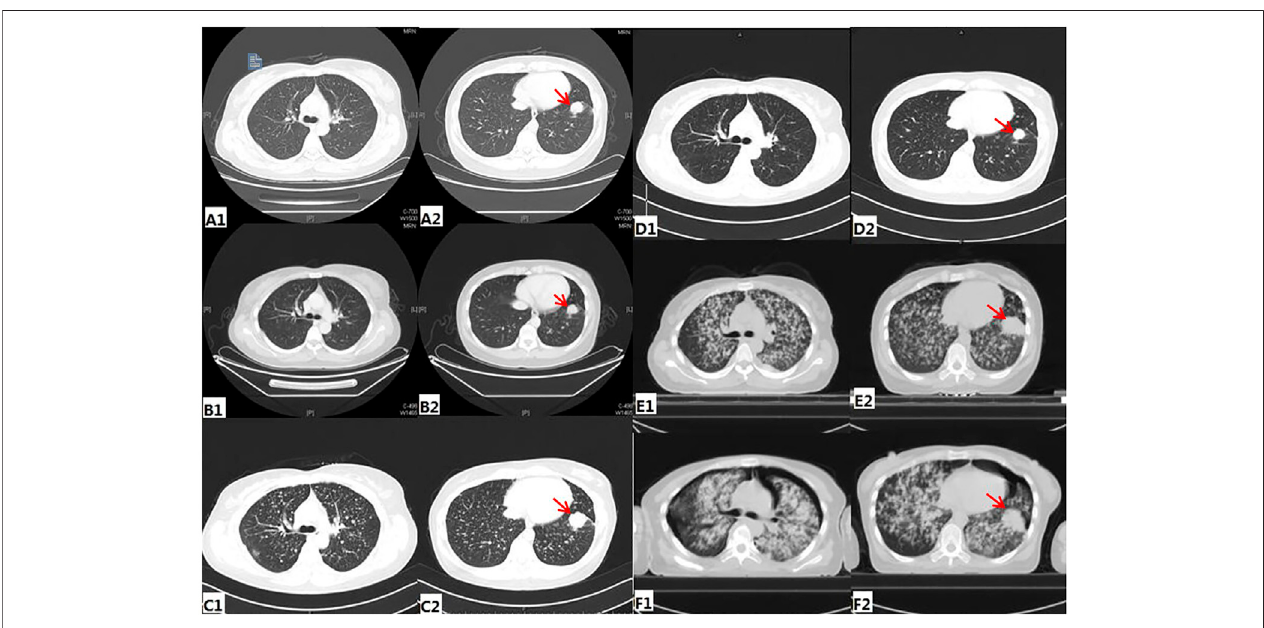
FIGURE1 | Radiologic fi ndings during treatment (A) before any treatment (B) Post-treatment image after three cycles of pemetrexed and cisplatin (C) before Afatinib treatment (D) CT of the chest showing PR after 1month of Afatinib (E) before nivolumab treatment (F) CT of the chest showing PD after 4 cycles of Nivolumab.